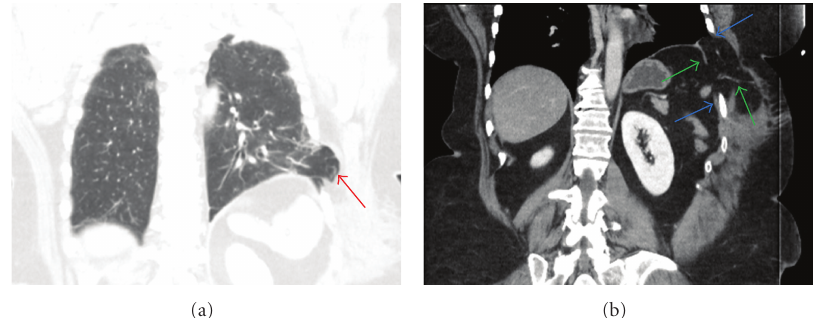
Figure 3: Coronal CT images of the abdomen demonstrate herniation of lung beyond the thoracic cavity (red arrow) (a). There is discontinuity of the diaphragm (green arrows) and widened intercostal space (blue arrows)